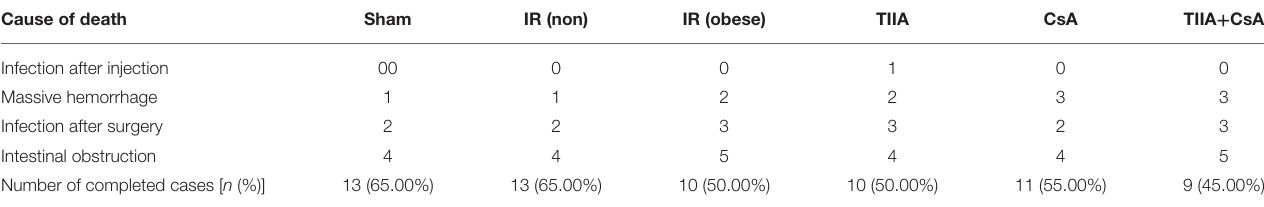
TABLE 1 | The cause of death in the six groups rats. Cause of death Sham IR (non) IR (obese) TIIA CsA TIIA + CsA Infection after injection 00 0 0 1 Massive hemorrhage